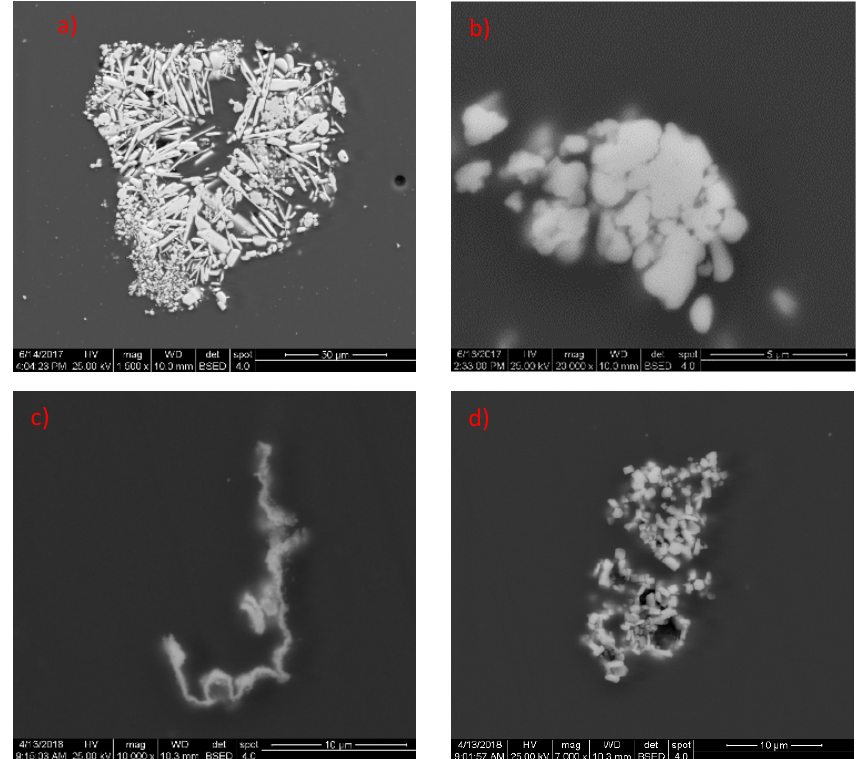
Figure 2. BSE images (1000×) of the micro-textures of ( a ) SSV_B1 blue- and ( b ) SSV_W1 white-colored natron- based tesserae from the monastic complex of San Severo in Classe, Ravenna, Italy—unpublished data. Note that only sporadic inclusions are detectable.